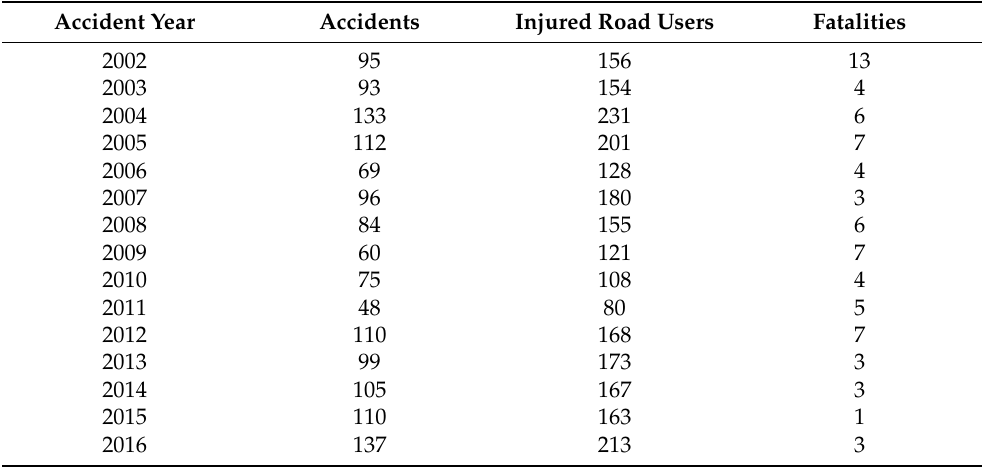
Table 1. Accidents in tunnels with a length of more than 200 m on motorways and expressways in Austria